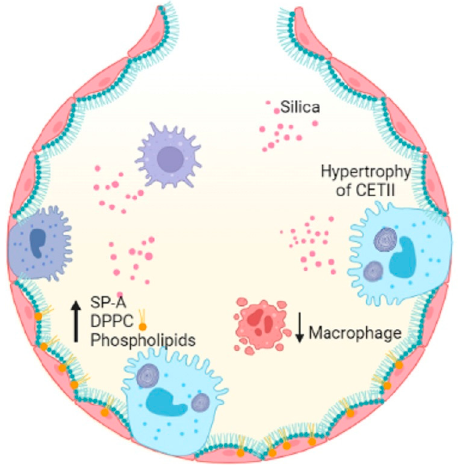
Figure 2. Silica entering the alveolar space decreases the number of macrophages, induces hyper- trophy of ATII cells and results in increased SP-A, DPPC and PLs, damaging alveolar homeostasis. Figure created in BioRender.com.